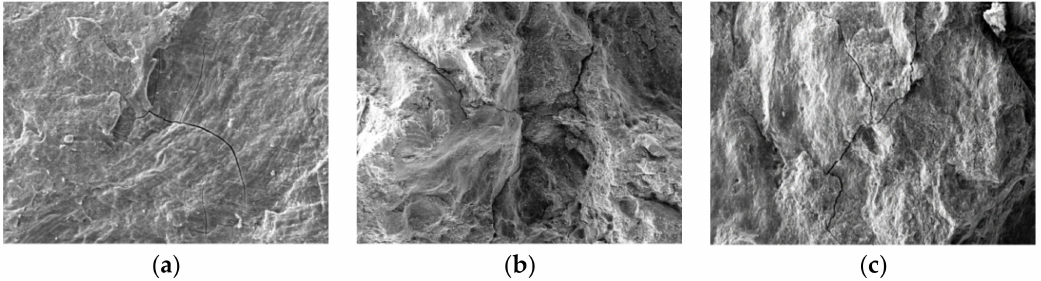
Figure 5. SEM results of the roadway surrounding rock [25]: ( a ) coal (150 times larger); ( b ) mudstone (100 times larger); ( c ) tu ff (100 times